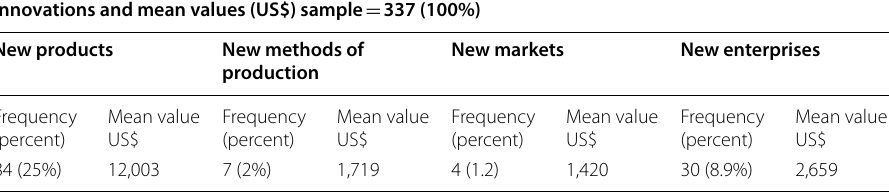
* Exchange rate: US$ 1